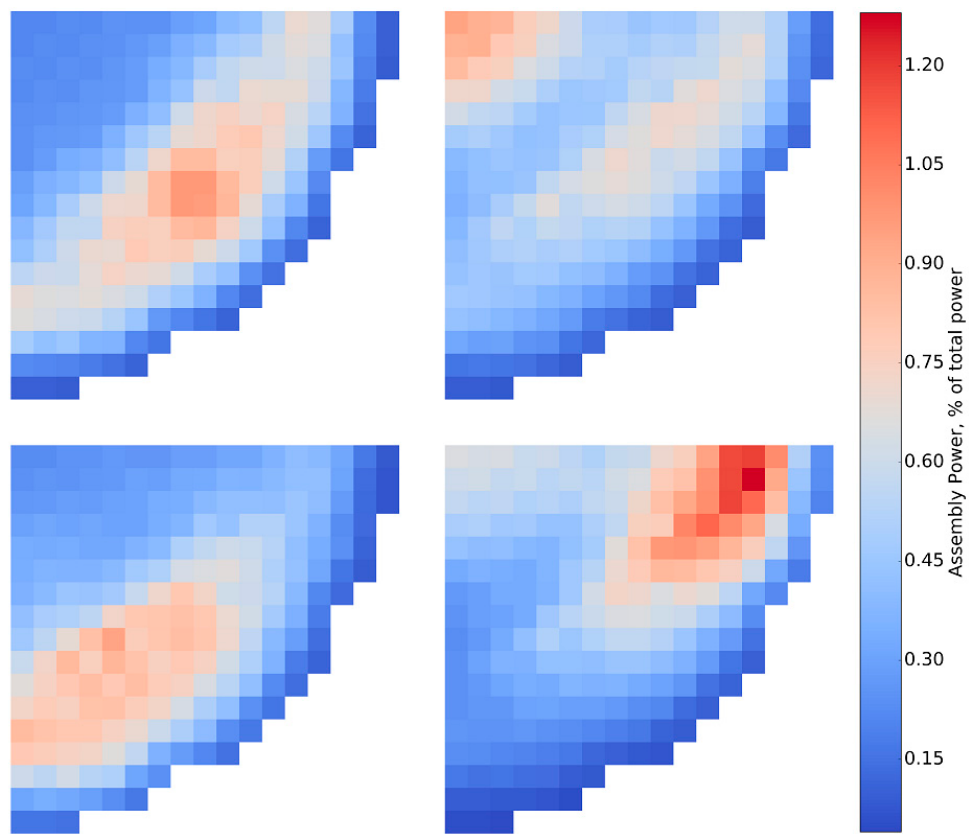
Figure 29. Power profiles from Serpent per iteration between Serpent and CTF where the assembly power % is proportional to the total reactor power (100%). Top left, stage zero (purely neutronic), top right, stage 1 coupled, bottom left, stage 2 coupled and bottom right, stage three coupled.